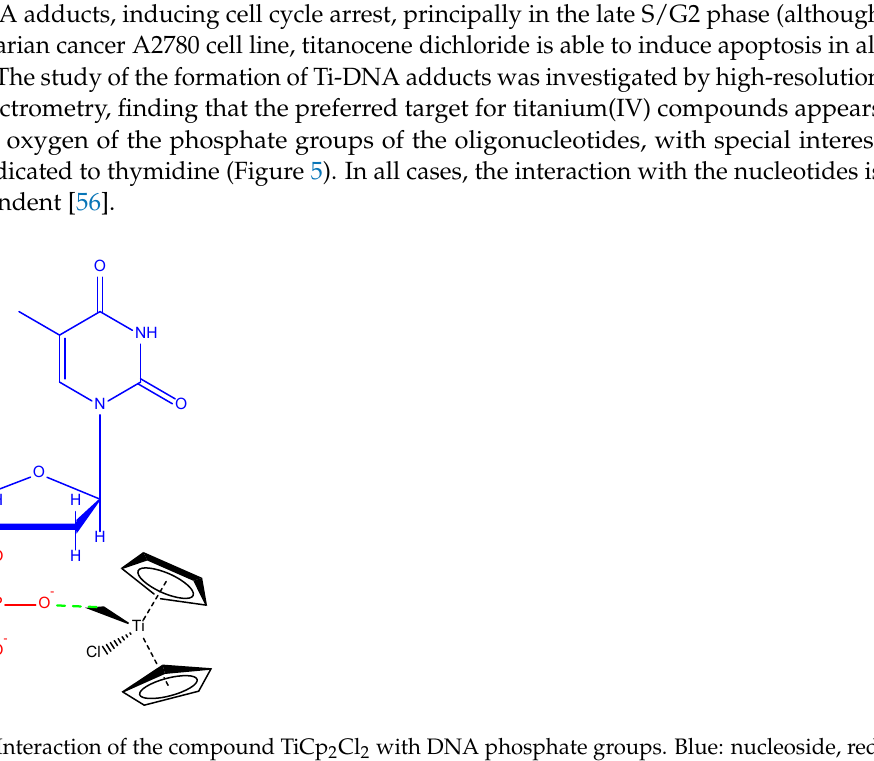
8 of 29 Figure 4. Scheme of Janus Pt-MSNs nanomotors with a catalytic self-propulsion for drug delivery by the catalytic reduction of H 2 O 2 mediated by glutathione [52]. Copyright © Authors of the publi- cation (open access).